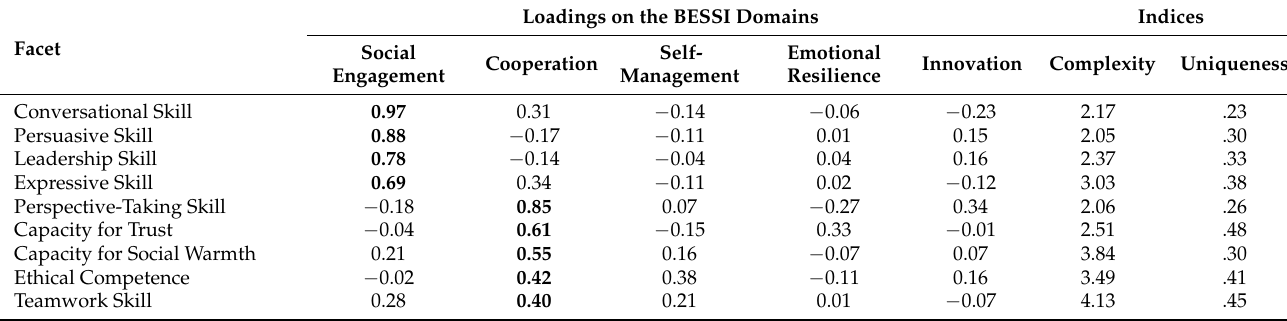
Table 4. EFA loadings for the BESSI-G facet